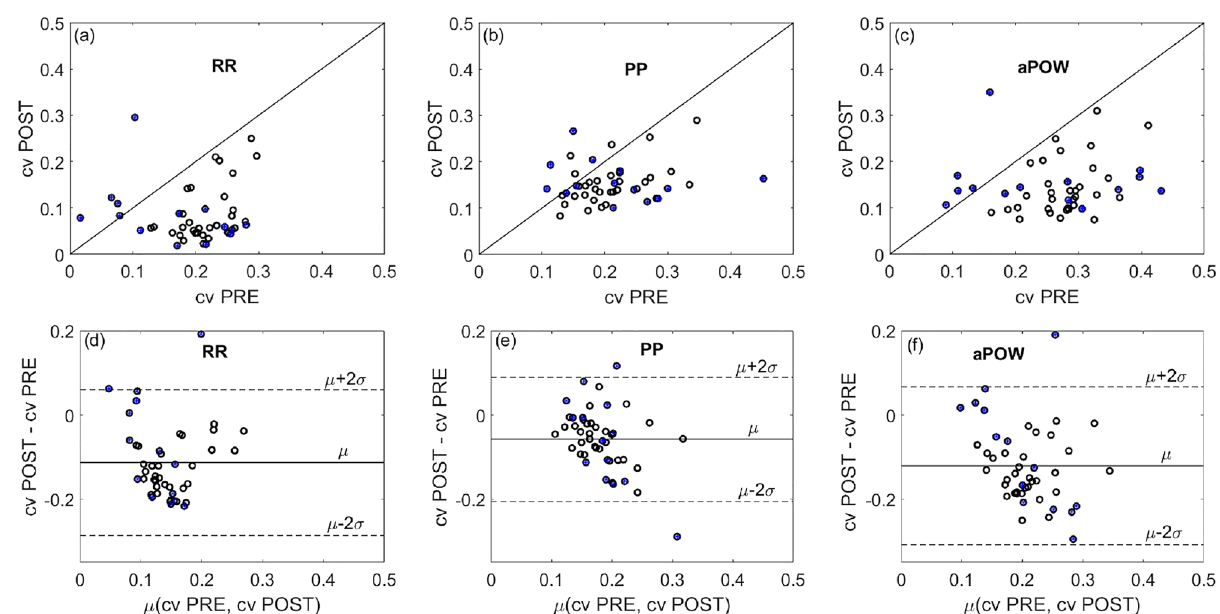
Figure 4. Scatter-plots (top panels: a – c ) and Bland–Altman plots (bottom panels: d – f ) of pre- and post-ECV cv values of RR interval (panels a and d ), PP (panels b and e ) and aPOW signals (panels c and f ) in the 46 patients included in the signal post-processing phase. Black open circles represent AF patients, while blue dots identify AFL